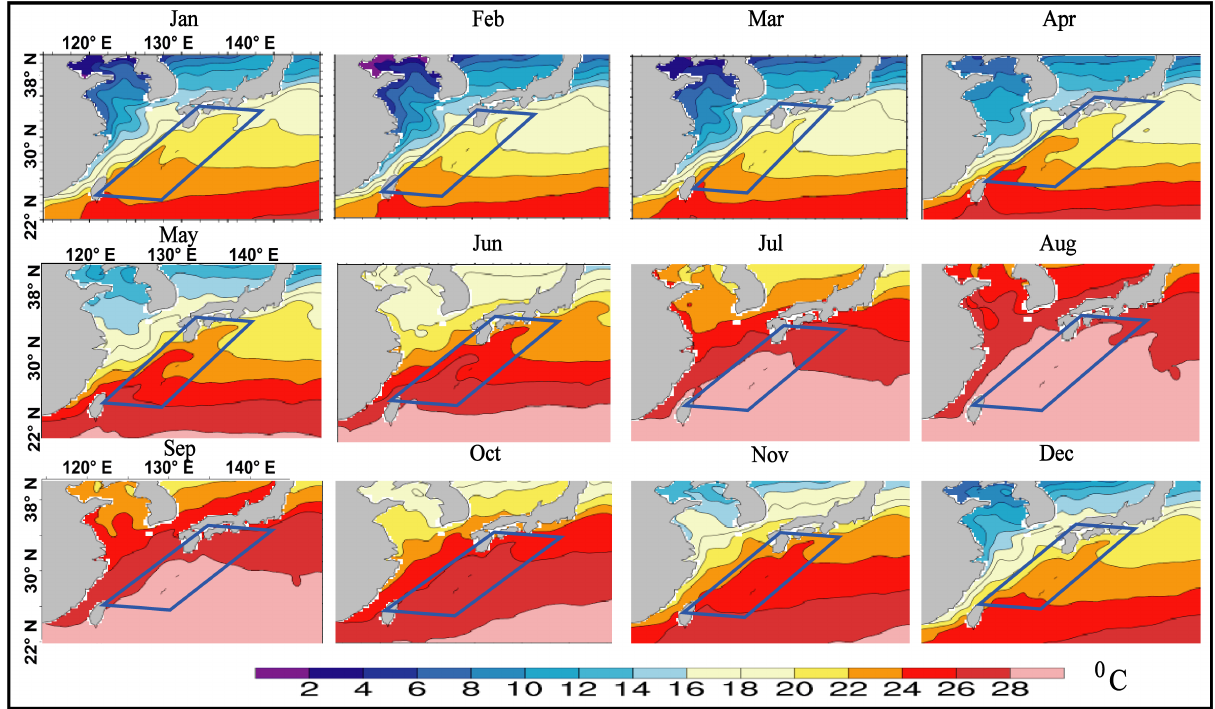
Figure 4. The SST climatology dispersal from 1993 to 2007. The blue polygon is a zone of Kuroshio warm tongue recreated for our study area using OISST version 2.0 by employing isotherm of 23 ◦ C as per proposed by Wang et al. [130]